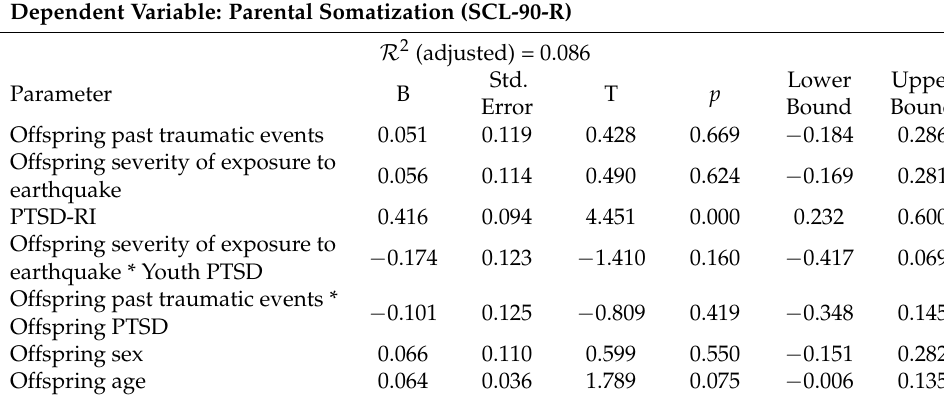
Table 4. General linear model for the SCL-90-R in the